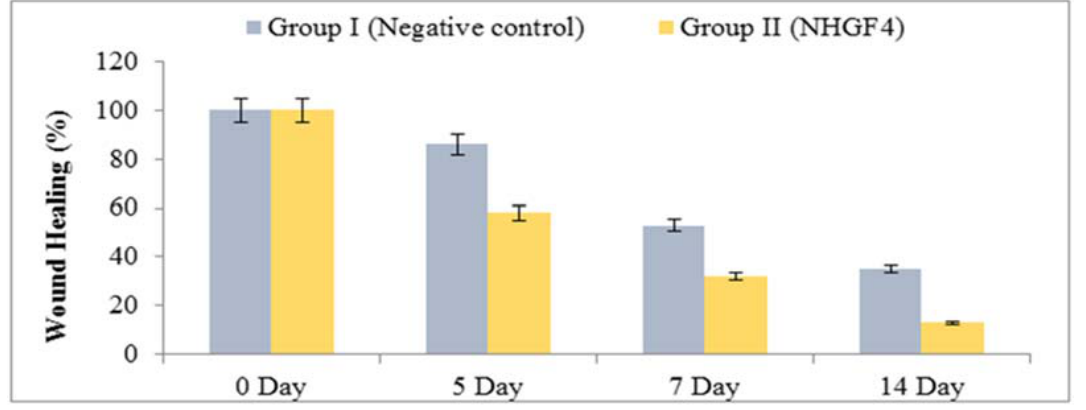
Figure 9. In vivo wound healing activity of SNPs embedded with NHGF4.